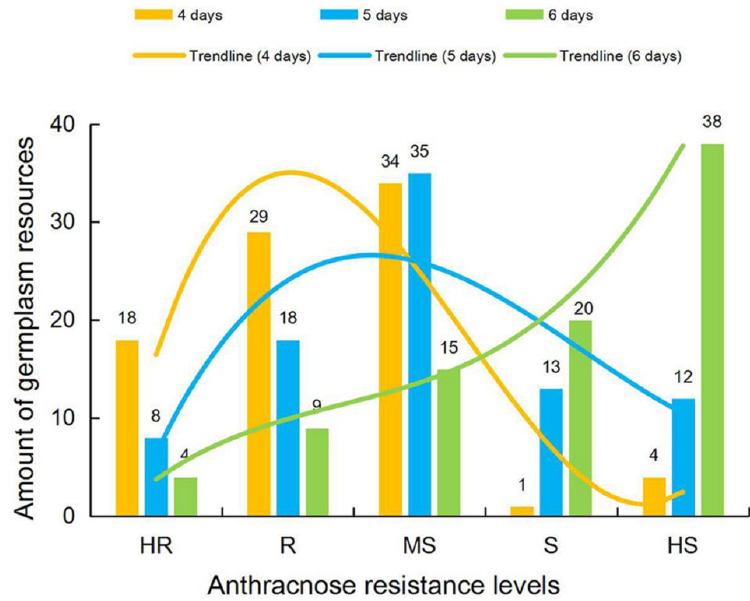
Figure 3. Number of soybean accessions at each level of soybean anthracnose resistance, at three different post-inoculation incubation times. HR, highly resistant; R, resistant; MS, moderately susceptible; S, susceptible; HS, highly susceptible.